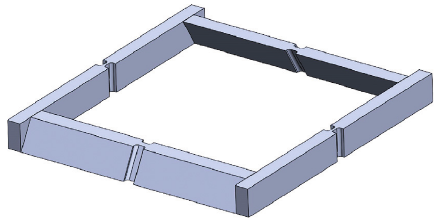
Figure 5: Auxetic cell design.